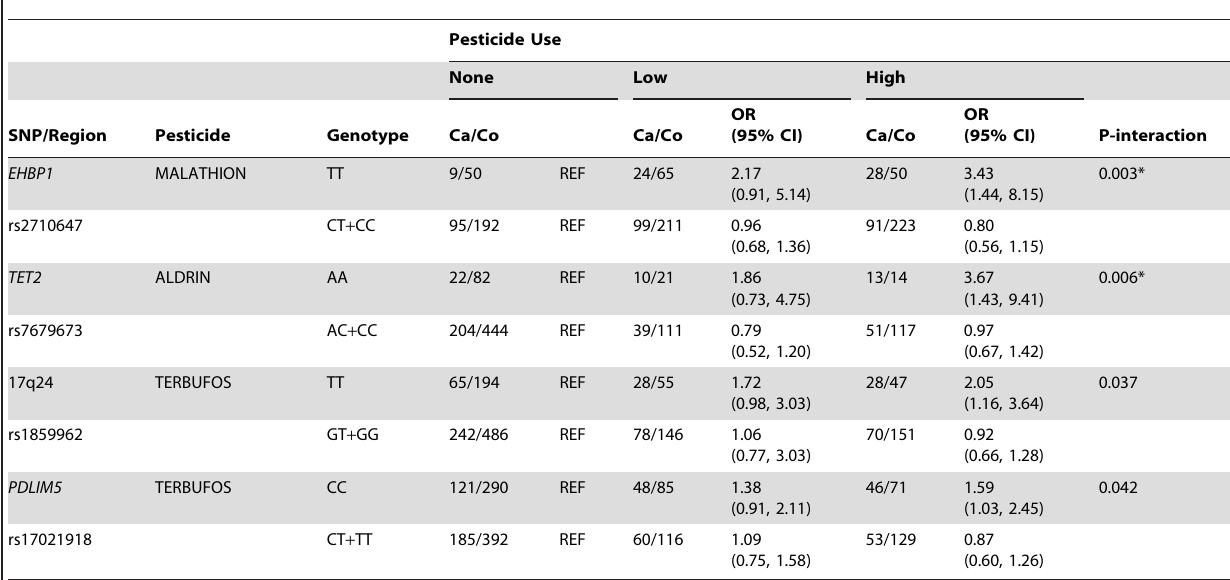
Table 3. Stratified odds ratios and 95% CI, adjusted for age and state, for associations between pesticides and prostate cancer.